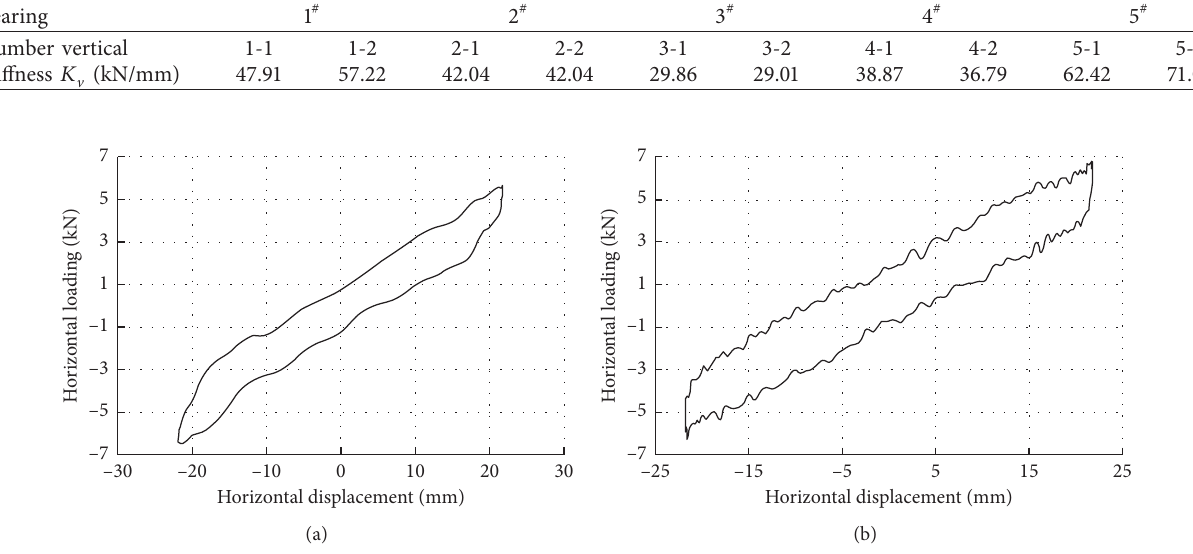
Figure 19: 1# bearing third hysteretic loop comparison: (a) 0.5Hz loading frequency; (b) 0.1 Hz loading frequency.